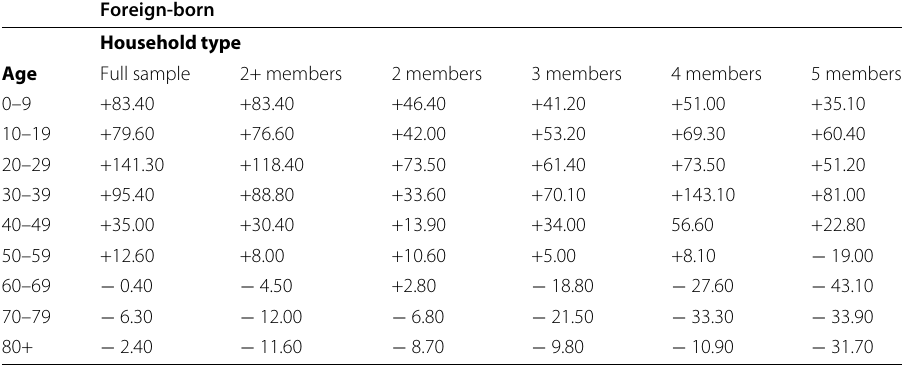
person from the reference category